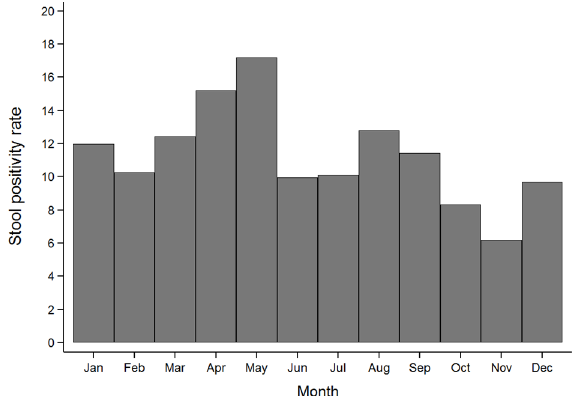
Fig 2. Seasonal fluctuations in the monthly occurrence of episodes of norovirus-associated diarrhea. The y-axis represents the monthly stool positivity rates (proportion of diarrheal episodes attributed to norovirus divided by the total number of diarrheal episodes). The x-axis represents the month of the